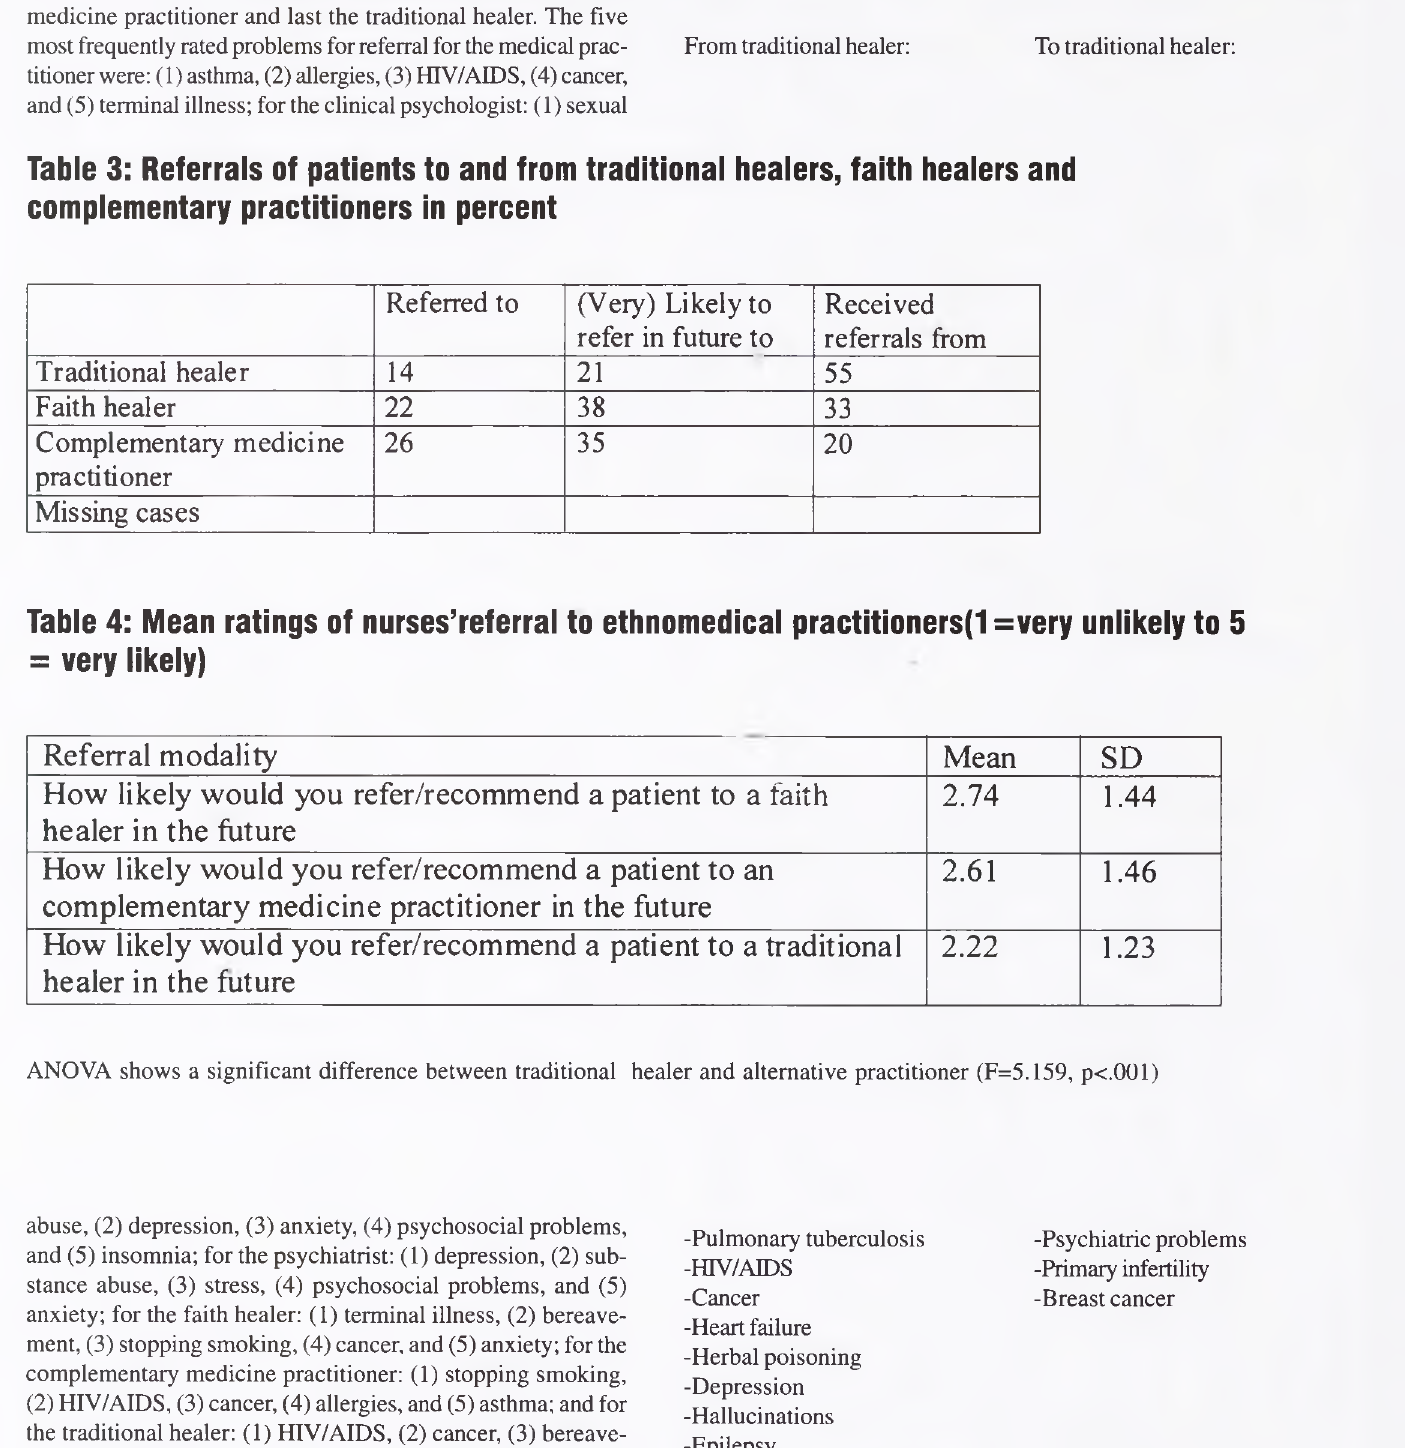
Table 3: Referrals of patients to and from traditional healers, faith healers and complementary practitioners in percent Referred to